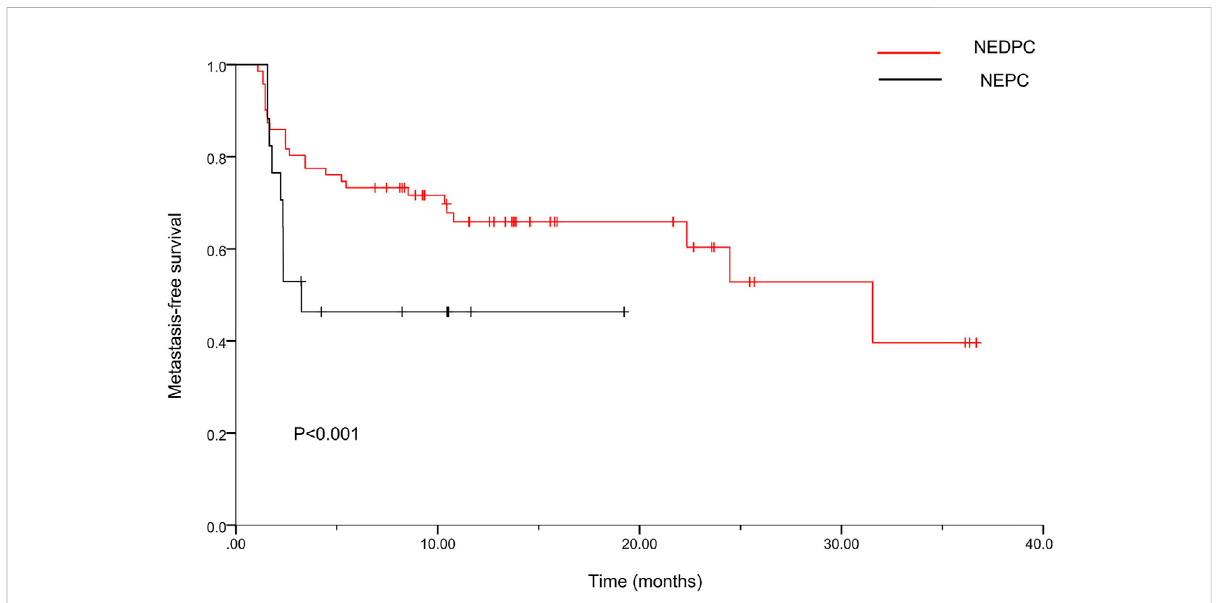
FIGURE 2 Kaplan-Meier curves for metastasis-free survival (MFS) of two groups. For the NEDPC group, the median MFS was 23.2 months (95% CI, 19.2 – 27.2). For the NEPC group, the median MFS was 10.1months (95% CI, 5.9 –